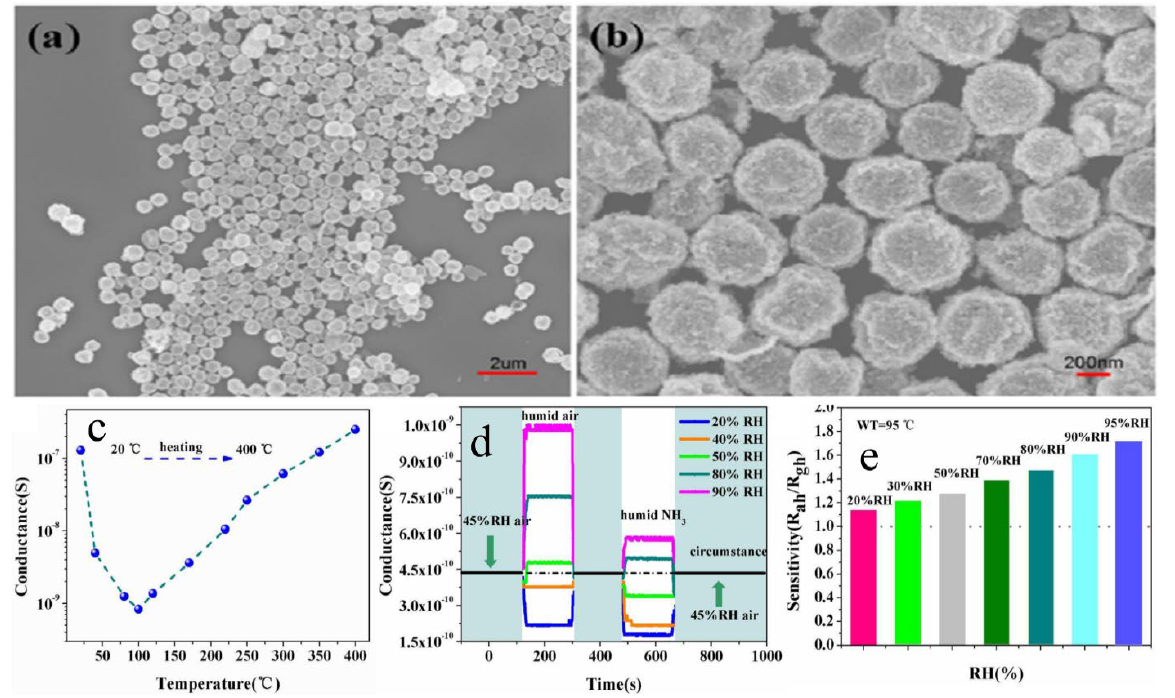
Figure 10. ( a , b ) SEM of the WO 3 − SnO 2 hollow nanospheres. ( c ) Temperature − dependent conduct- ance of the gas sensor. ( d ) Effect of humidity on the NH 3 sensing at 95 °C. ( e ) Improvement in gas sensitivity to 5000 ppm ethanol by increasing surrounding humidity from 20 to 95% RH. (Reprinted with permission from [75]. Copyright 2015, American Chemical Society, Washington, DC, USA).